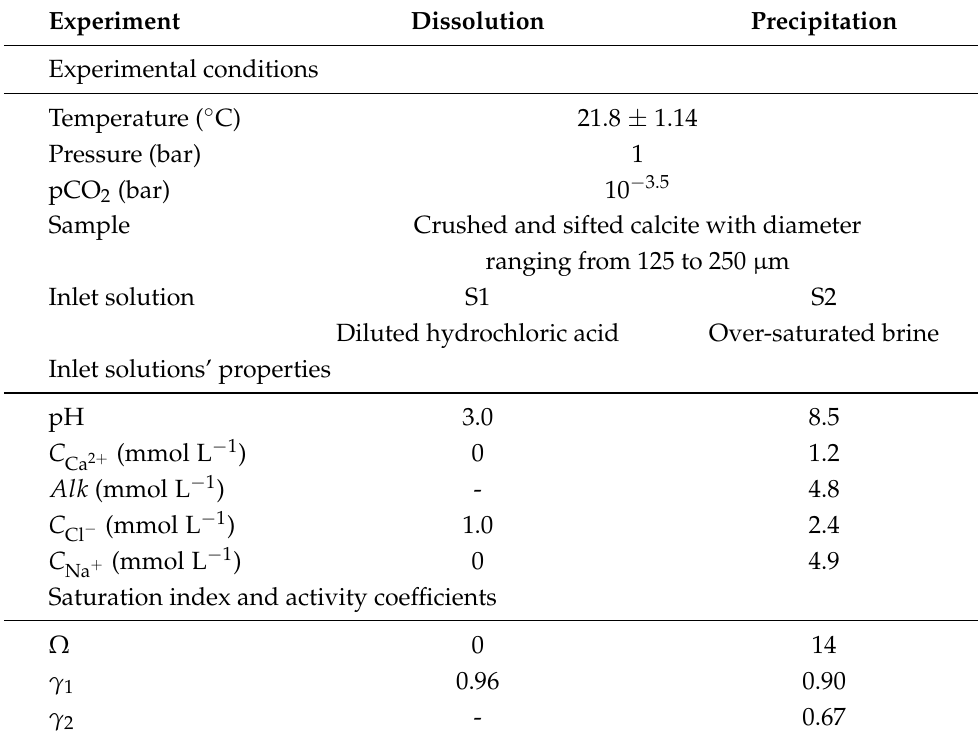
Table 4. Experimental conditions, chemical composition from high-performance liquid chromatog- raphy (HPLC) and inductively coupled plasma atomic emission spectroscopy (ICP-OES) analysis, experimental pH and alkalinity of the injected solutions (concentrations are given in mmol L − 1 ), and computed saturation index for calcite and activity coefficients. The bicarbonate concentration is assumed to present identical values with alkalinity measurements in the pH range. γ 1 corresponds to the activity coefficient of all ions with a valence of 1 (e.g., H + and HCO − the activity coefficient of all ions with a valence of 2 (e.g., Ca 2 +